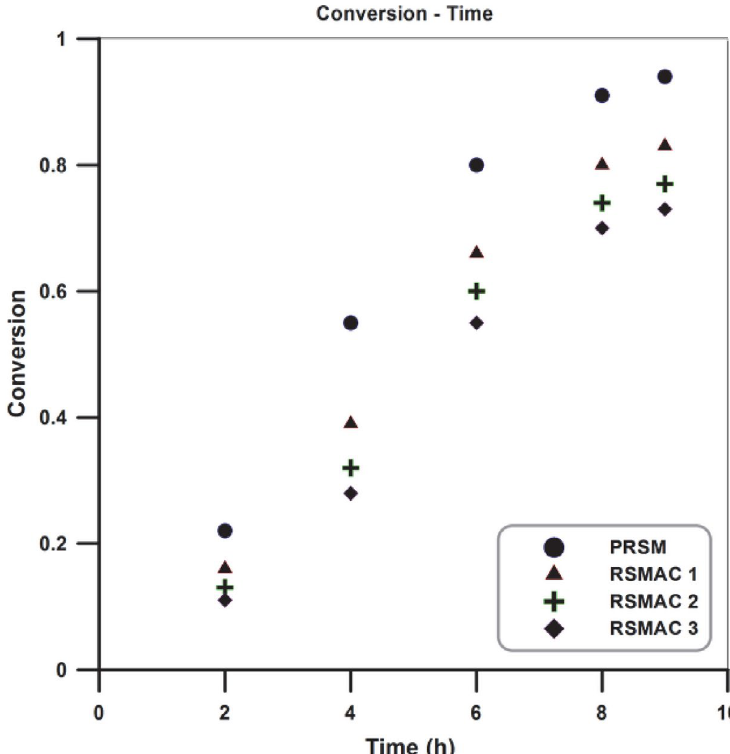
Figure 5. Variation of monomers conversion with time for the PRSM and RSMAC